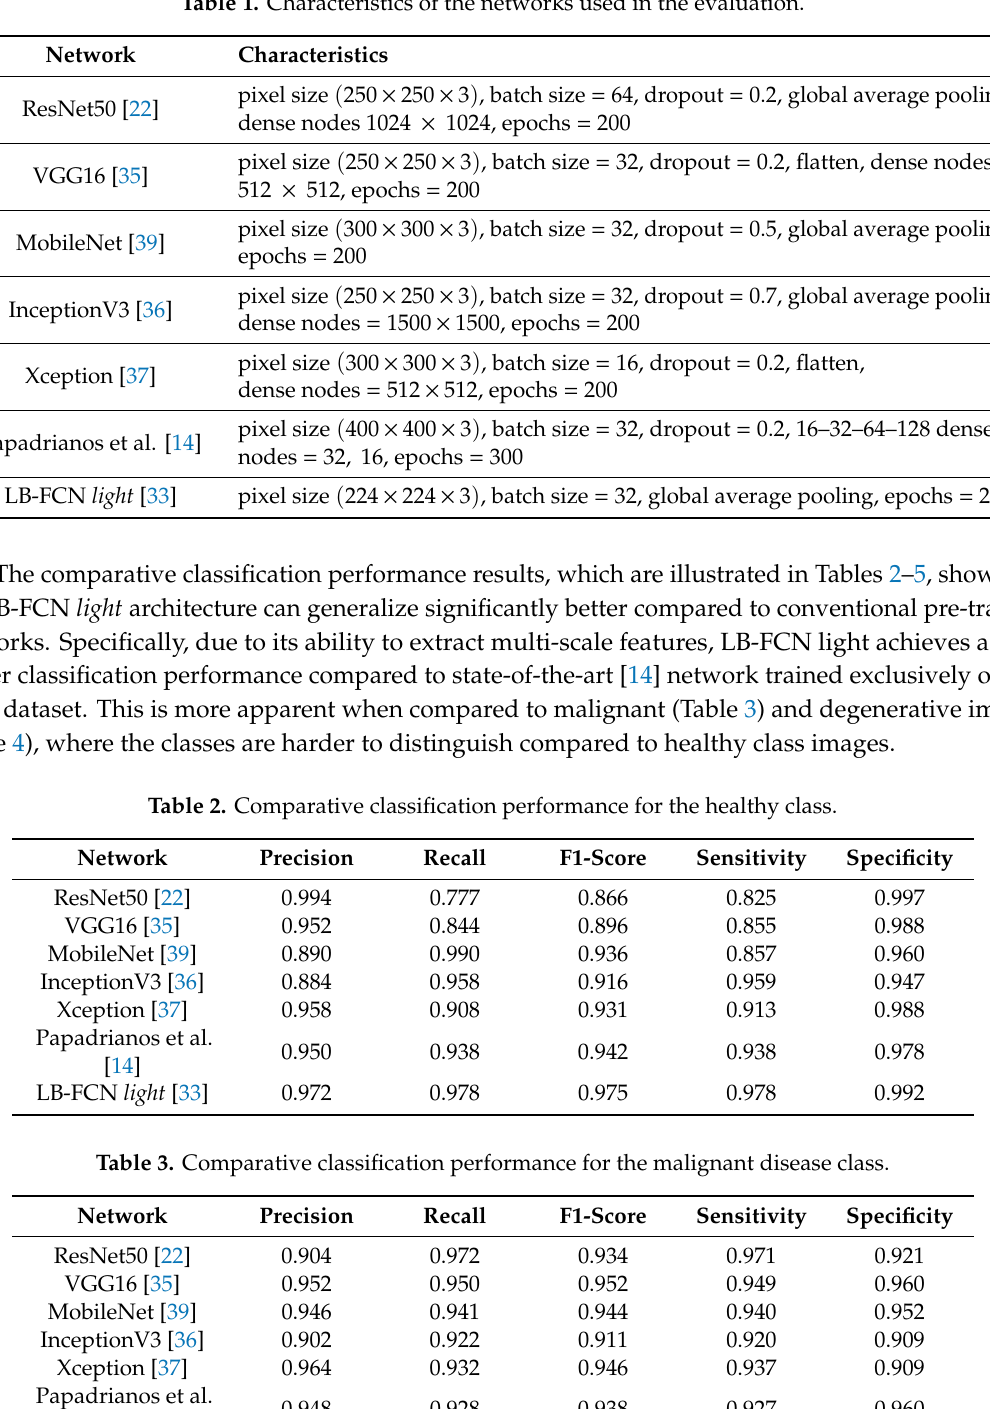
Table 1. Characteristics of the networks used in the evaluation.